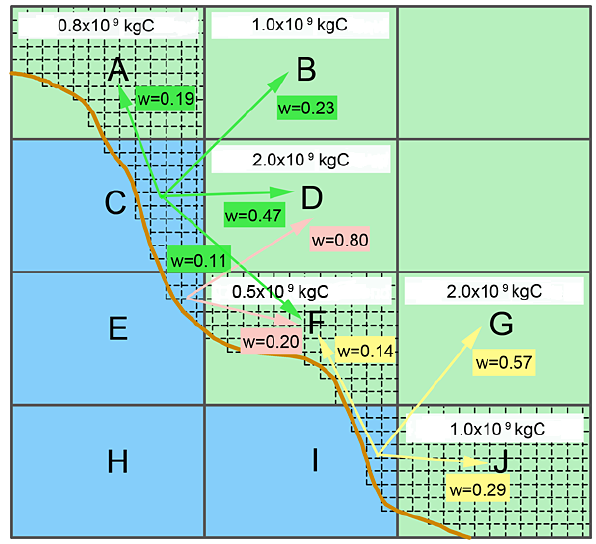
Figure 2. Depiction of the “shuffling” procedure when regridding from a 0.1 ◦ × 0.1 ◦ to a 1.25 ◦ × 1.0 ◦ model grid. Capital black let- ters denote the coarser model grid (1.25 ◦ × 1.0 ◦ ). Grid cells out- lined with dashed lines denote the finer model grid (0.1 ◦ × 0.1 ◦ ). Green denotes land, and blue denotes water. Example emission val- ues and weighting values ( w) and the direction of the allocation are included.